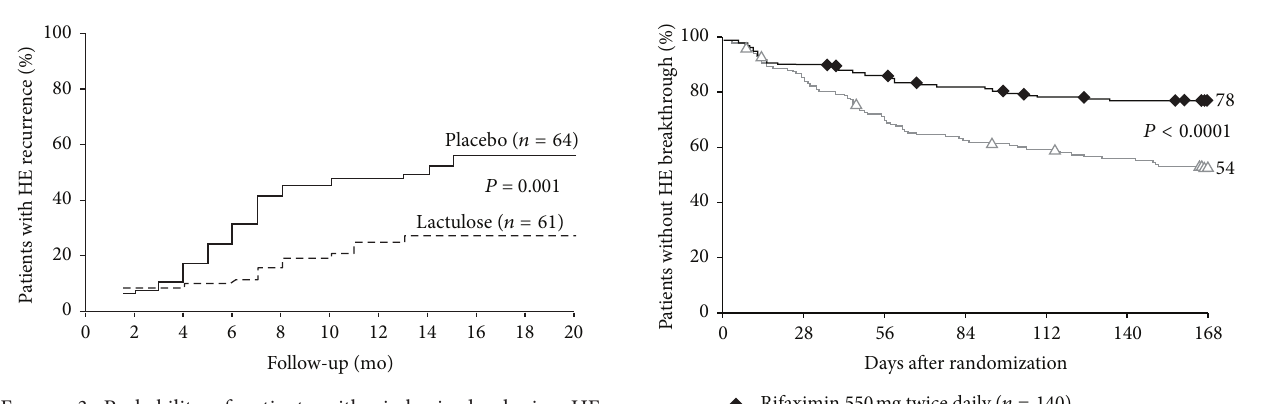
Figure 3: Probability of patients with cirrhosis developing HE recurrence during daily treatment with lactulose or placebo. HE, hepatic encephalopathy. Reprinted from Sharma et al., Copyright © 2009, with permission from W. B. Saunders Co. [49].